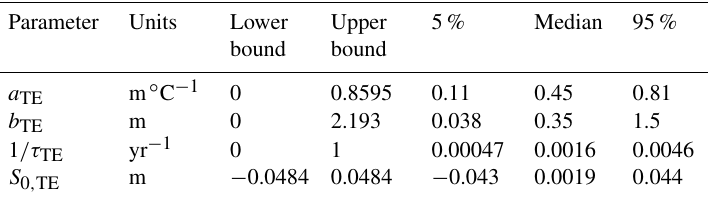
Table A2. Prior probability distribution ranges for the thermal ex- pansion model parameters, and median, 5th, and 95th quantiles of the calibrated posterior parameter distributions. The prior distribu- tion for 1 /τ TE is a gamma distribution (see main text). The other priors are all uniformly distributed.